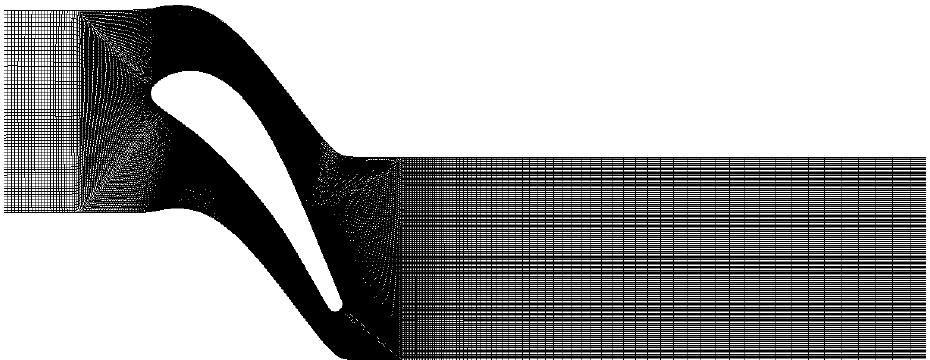
Figure 11. Grid for simulating VKI turbine